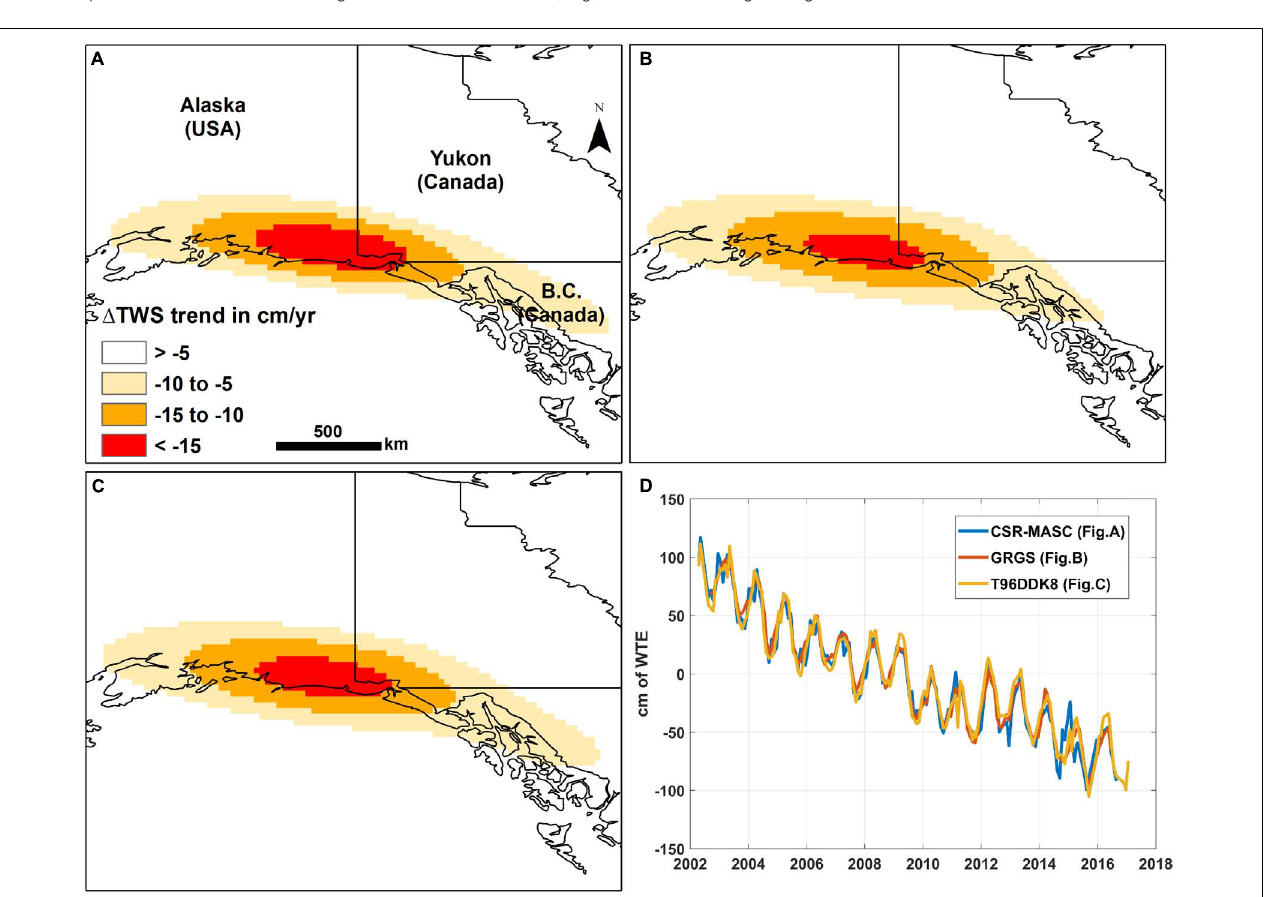
FIGURE 4 | TWS signal trend over the study area using the three GRACE solutions: (A) CSR-MASC, (B) GRGS, (C) T96DDK8, and (D) near-monthly time-series of TWS change in WTE for the period 2012–2017 observed at the center of the anomaly.